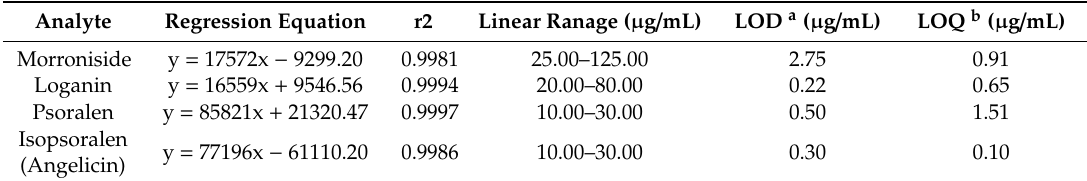
Table 1. Regression data, LODs and LOQs for the 4 analytes of the assay.